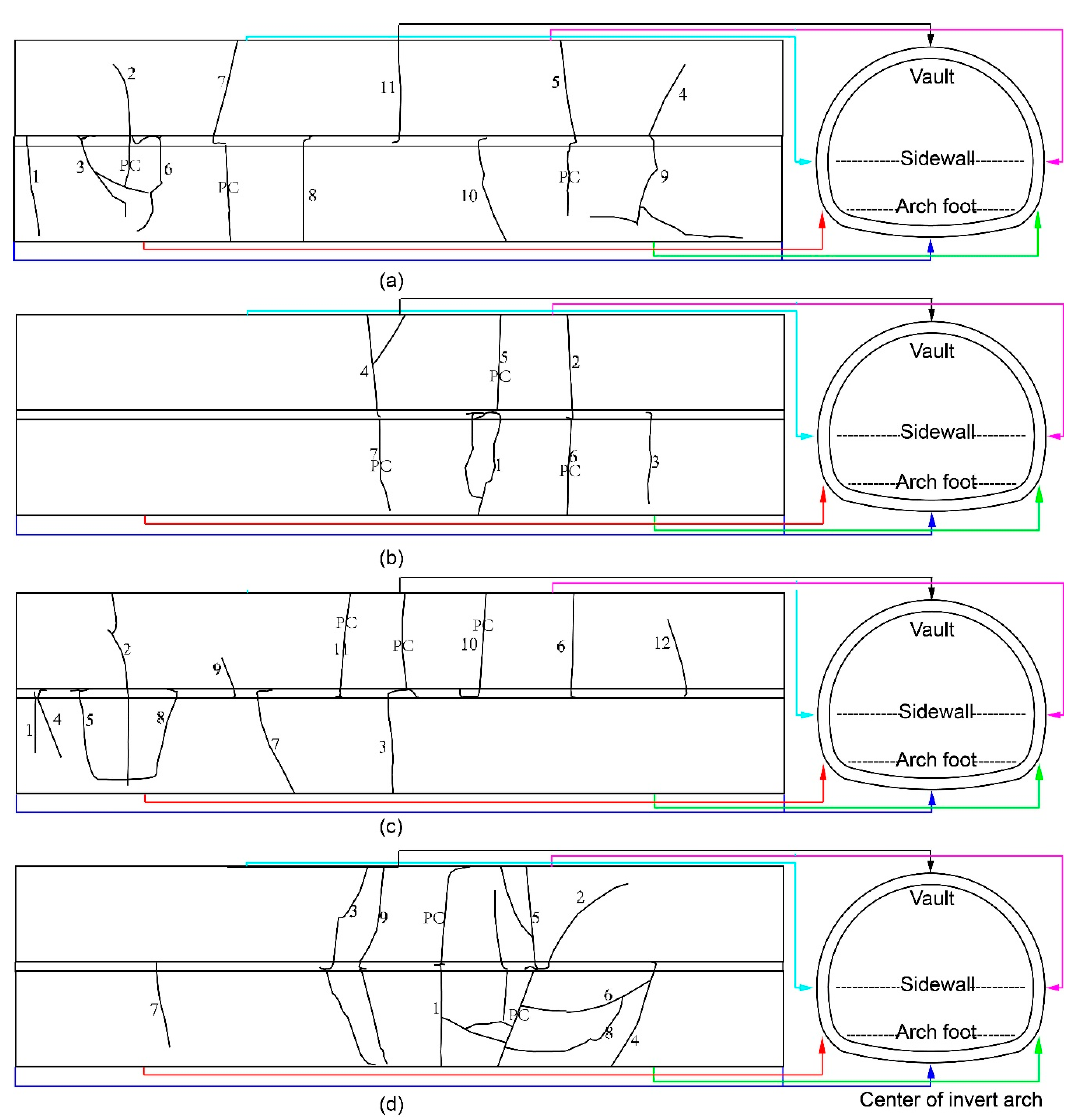
Figure 16. Cracks distribution of secondary lining. ( a ) Case 1, ( b ) Case 2, ( c ) Case 3, and ( d ) Case 4.